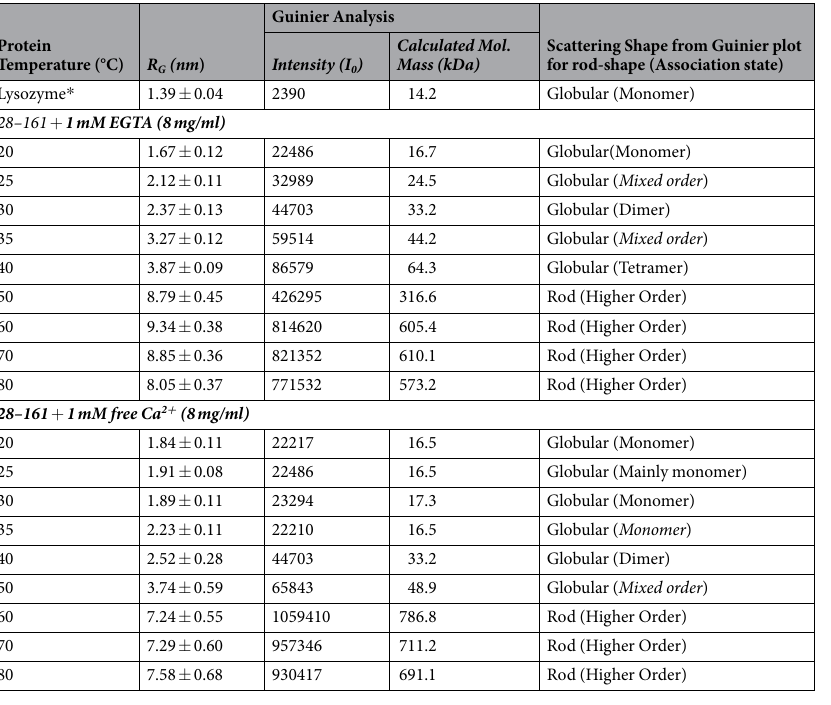
Table 1. The radius of gyration ( R G ) and molecular mass ( kDa ) calculated from forward scattering intensities ( I 0 ) estimated from the Guinier region of the SAXS data are tabulated here. * Estimated for 1 mg/ml of Lysozyme for same exposure time. N.B.: The molecular mass was calculated using this